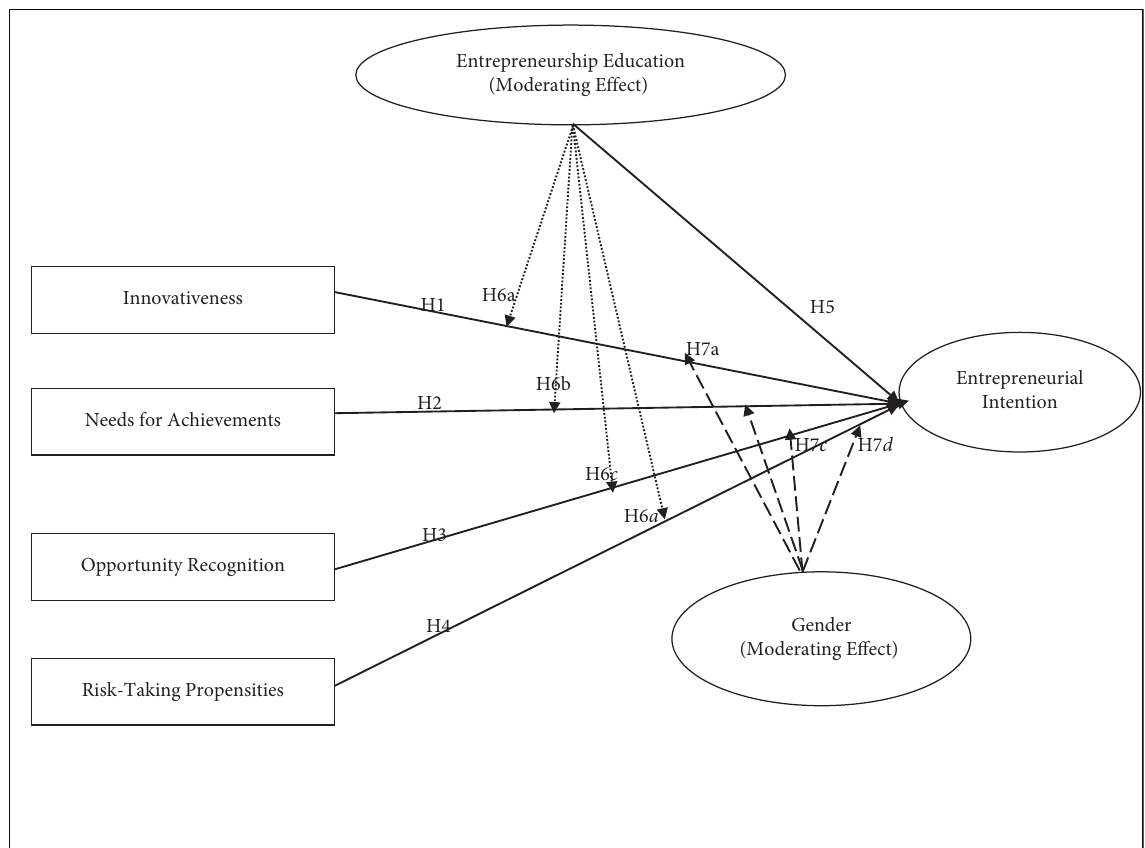
Figure 1: Conceptual framework. Source: prepared by